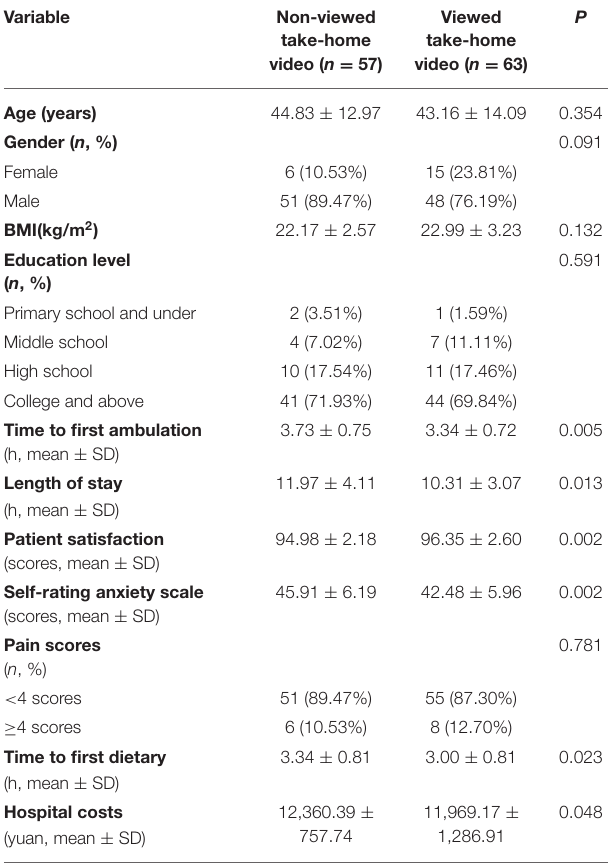
TABLE 1 | Baseline characteristics of participants [ n (%)/ mean ±